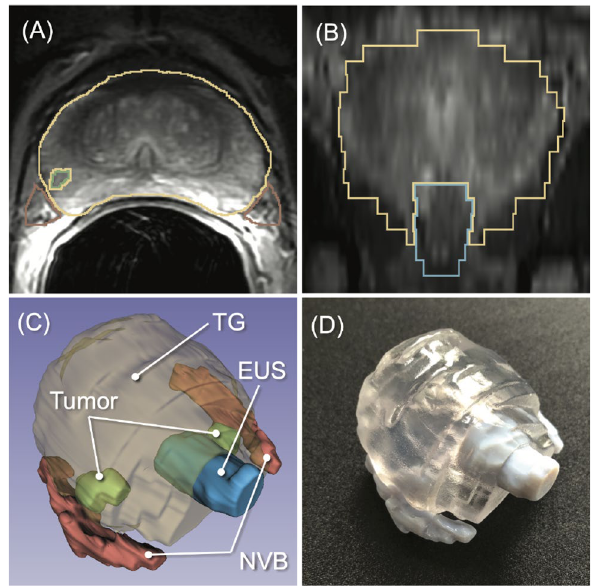
Figure 1. An example application of 3D segmentation of the prostate and adjacent structures for surgical planning. The prostate gland, neurovascular bundle (NVB), external urethral sphincter (EUS), and tumor are manually segmented on the preoperative T2-weighted MRI ( A , B ) by a radiologist, and then converted to a 3D surface model ( C ). The model can also be 3D-printed ( D ) for surgical planning, and preoperative communication with the